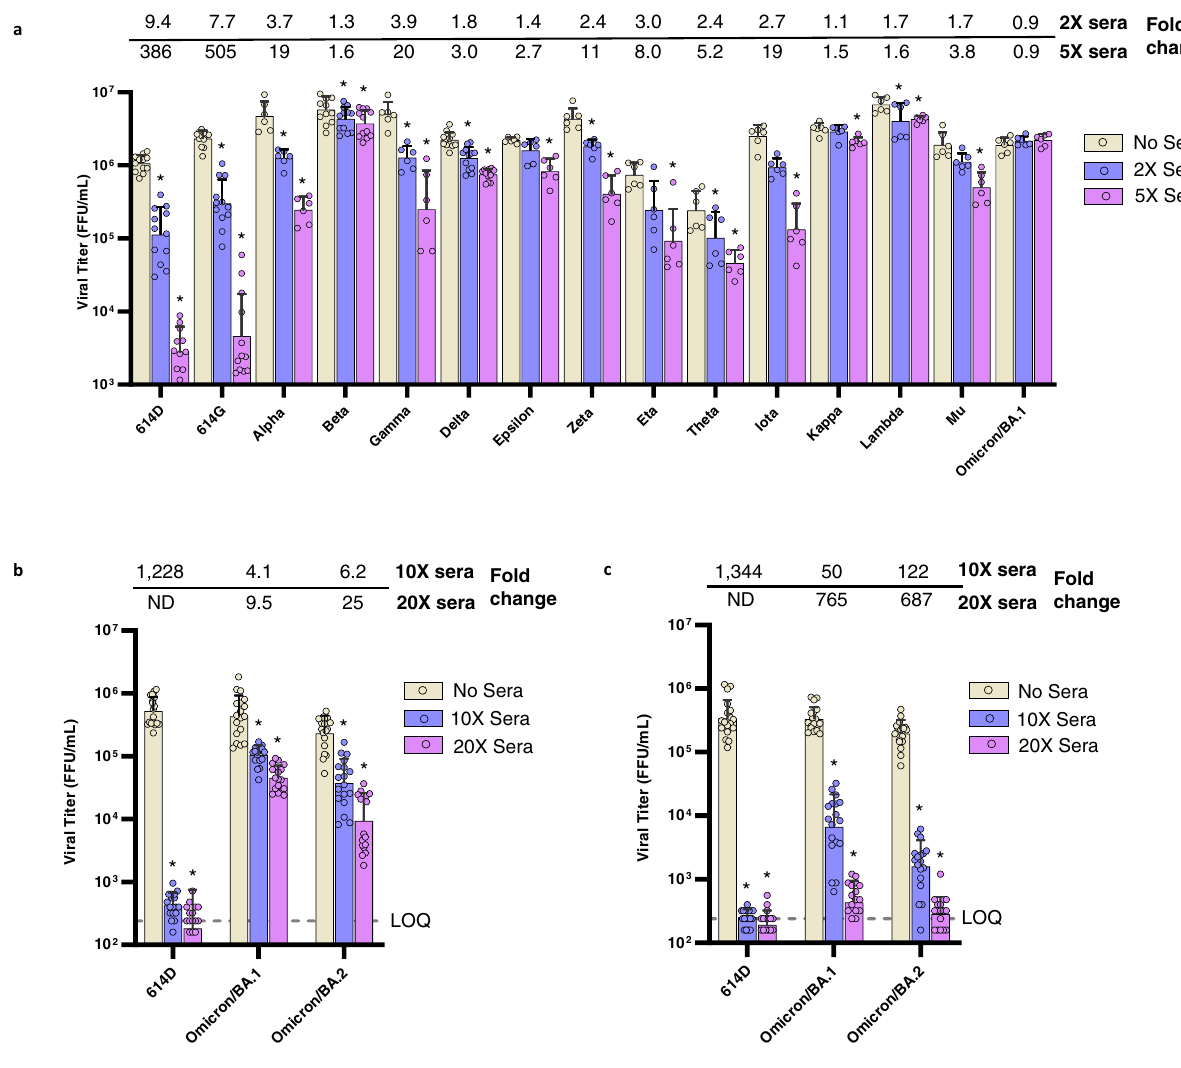
Fig. 5 Inhibition of mRNA vaccinee sera against live SARS-CoV-2 viruses. Calu-3 cells were infected with 200 – 400 focus forming units (FFU) of each virus and incubated for 2 days in media with or without sera. The viruses were collected from Calu-3 supernatant at 2 days post inoculation and titrated by FFU assay. The geometric mean viral titers of variants under different treatment conditions are represented in the graph as bars with geometric standard deviation. Bar graphs present the titers of each variant under different treatment conditions. Error bars representing titer differences are marked as *, representing p < 0.05, compared to the no sera control within each virus group. Two-tailed Wilcoxon matched-pairs signed-rank test was used for statistical signi fi cance analysis and the statistics and P value are summarized in Supplementary Table 2. Source data are provided as a Source Data fi le. Titer fold changes (reductions) compared to the no sera control are shown on the top of the panel. a The sera for incubation were pooled from the individual sera used in Fig. 2a and diluted to 2X or 5X concentration (diluted sera titer FRNT 50 = 2 or 5 against 614D reference virus). N = 6 or 12 viral titers over 2 biologically independent sera pools in 1 – 2 independent experiments. b The sera for incubation were pooled from the individual sera used in Fig. 2a (post-second dose) and diluted to 10X or 20X concentration (diluted sera titer FRNT 50 = 10 or 20 against 614D reference virus). N = 18 viral titers over 2 biologically independent sera pools in 1 – 2 independent experiments. The fold change for the 614D-20X sera group is not determined (ND) as the average viral titer of that group is below the LOQ. c The sera for incubation were pooled from the individual sera used in Fig. 3b (post-third dose) and diluted to 10X or 20X concentration (diluted sera titer FRNT 50 = 10 or 20 against 614D reference virus). N = 18 viral titers over 2 biologically independent sera pools in 1 – 2 independent experiments. The fold change for the 614D-20X sera group is not determined (ND) as the average viral titer of that group is below the LOQ. Yellow bars, viral titers in the absence of sera; blue bars, viral titers in 2X or 10X sera; purple bars, viral titers in 5X or 20X sera. Limit of quanti fi cation LOQ = 240